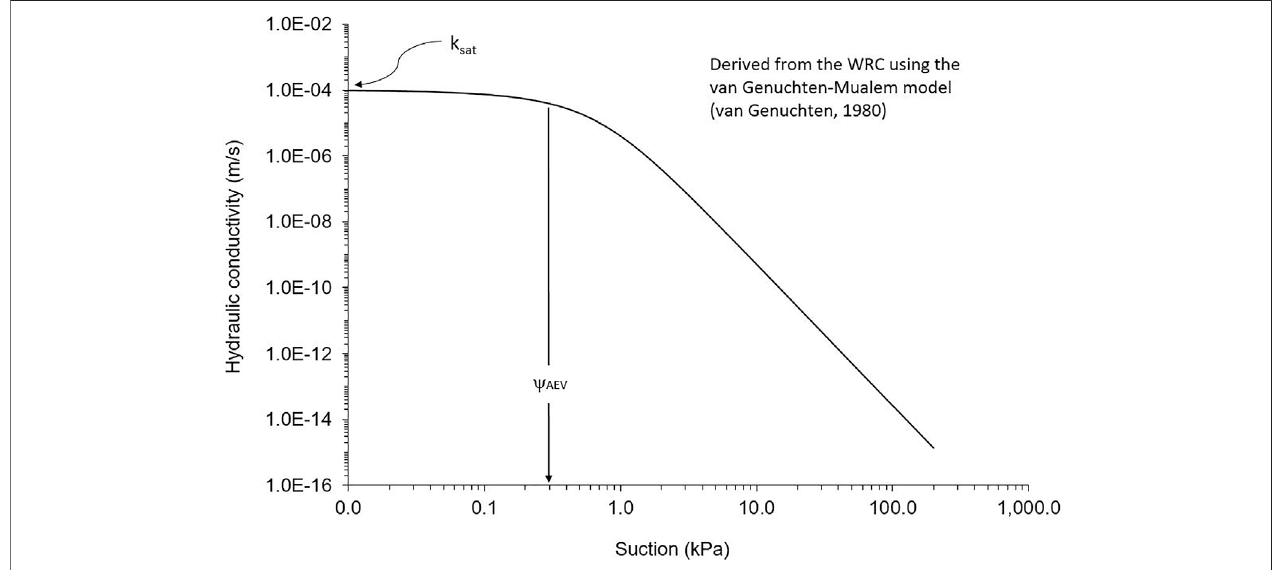
FIGURE 2 | Hydraulic permeability function (k-fct) of the same soil in Figure 1 .